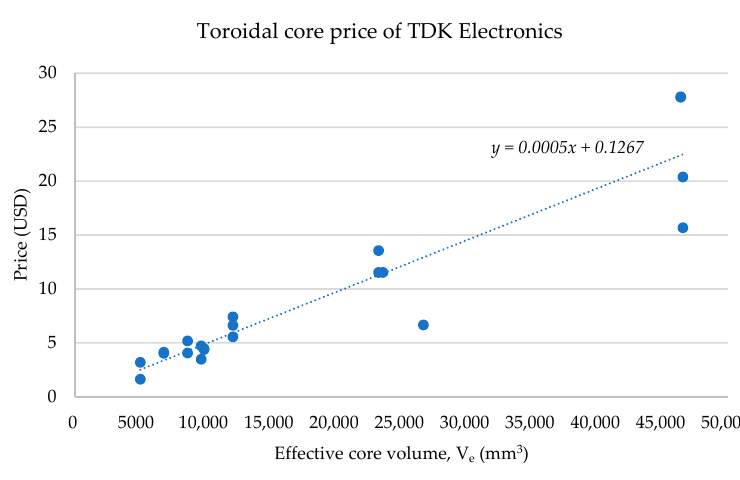
Figure 11. Price distribution of Ferrite core by effective volume: ( a ) ETD core for transformer; ( b ) Toroidal core for inductor.